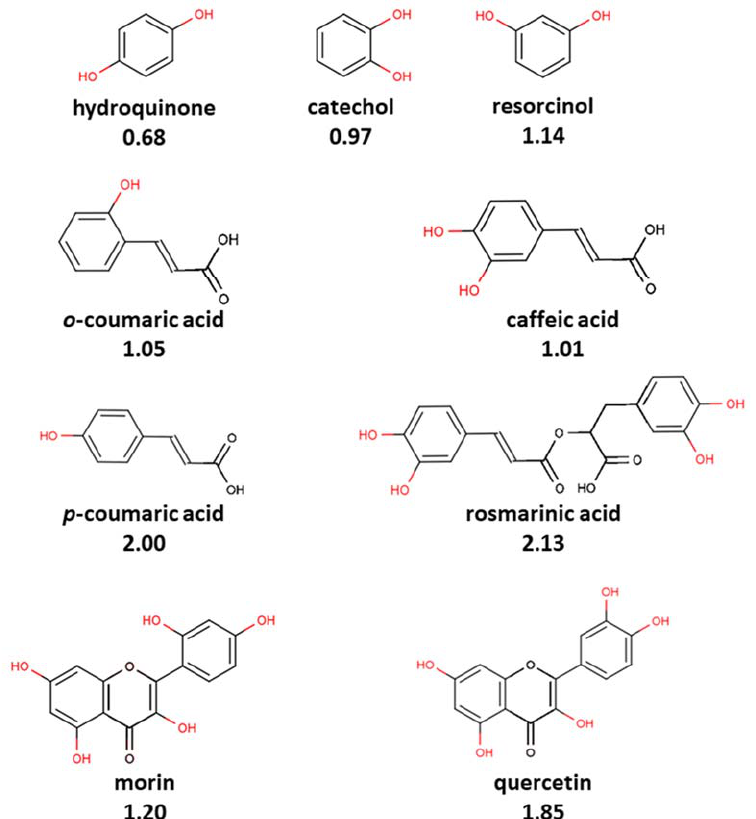
Figure 3. The number of hydroxyls does not always correlate with the TEAC value in ABTS/PP assay [71]. Hydroquinone, catechol, and resorcinol have the same number of hydroxyl groups, but there is a sufficient difference in the TEAC value, as well as in case of morin and quercetin. However, p-coumaric acid and rosmarinic acid showed the same TEAC-value, as well as o-coumaric acid and caffeic acid, in spite of twofold and fourfold differences in the number of hydroxyl groups, respectively. The TEAC values in ethanol are given under the name of each compound.